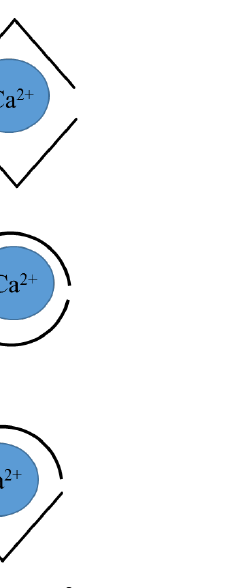
Figure 3. P Possible structures of alginate chelates with Ca 2+ : ( a ) GG/GG, ( b ) MG/MG, ( c )